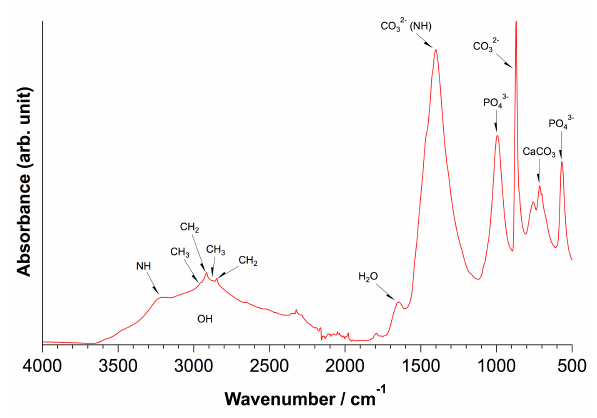
Figure 2. Fourier transform infrared spectrum of the powdered urinary stone.